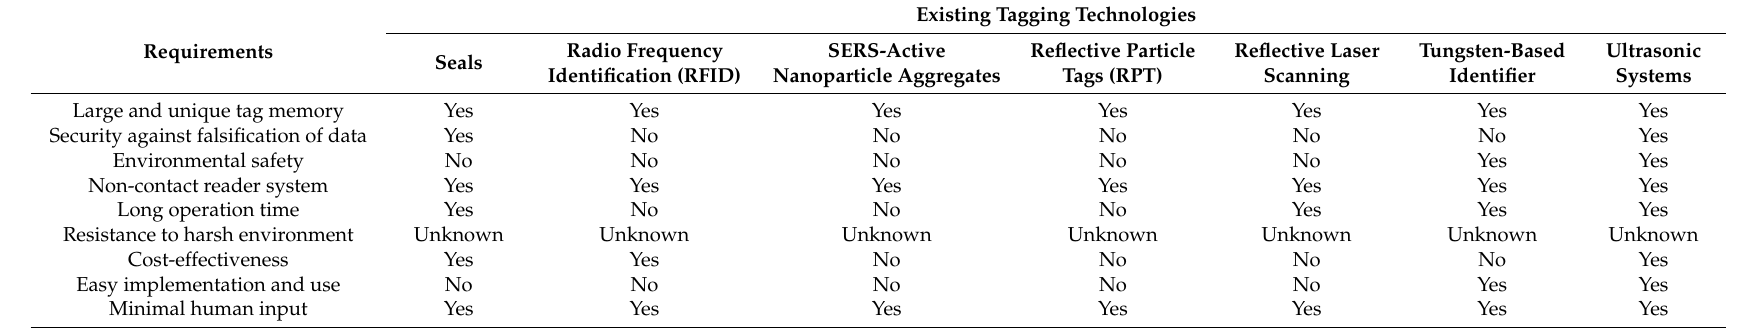
Table 1. List of existing tagging technologies that fulfill or not the requirements for copper canisters